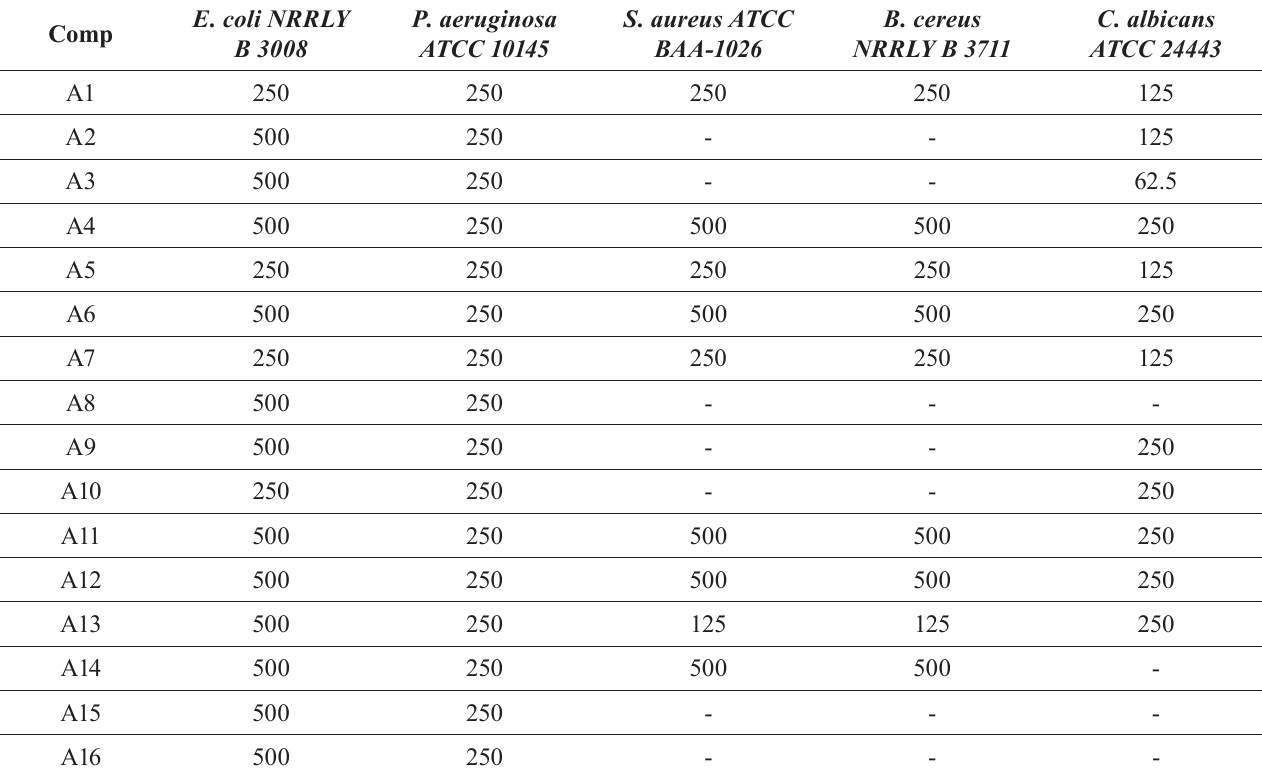
TABLE II – MIC (µg/mL) of the compounds series V(A1-A24, B1-B39)